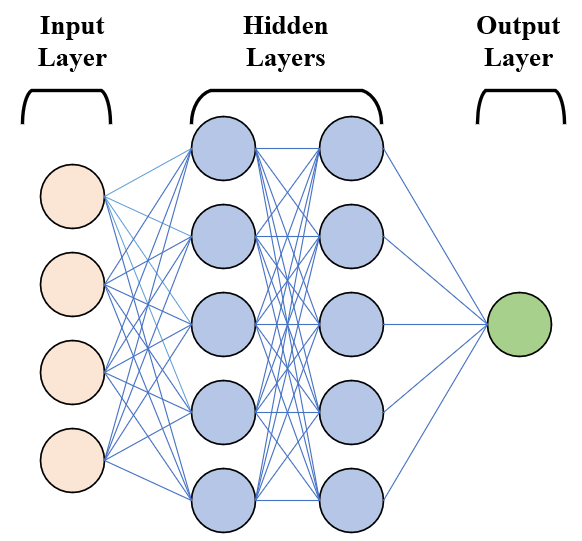
Figure 1. The FNN Figure 1. The FNN structure.